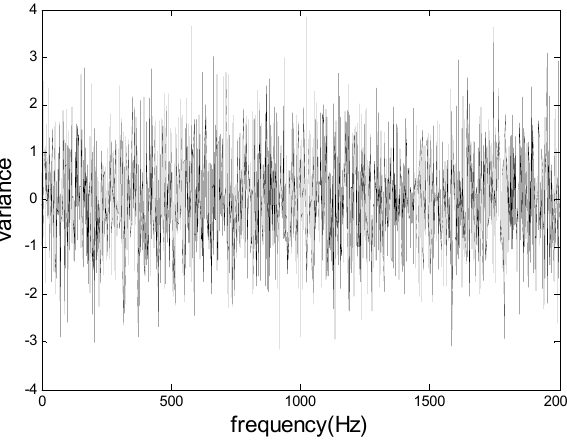
Figure 9. The white noise excitation in frequency domain.